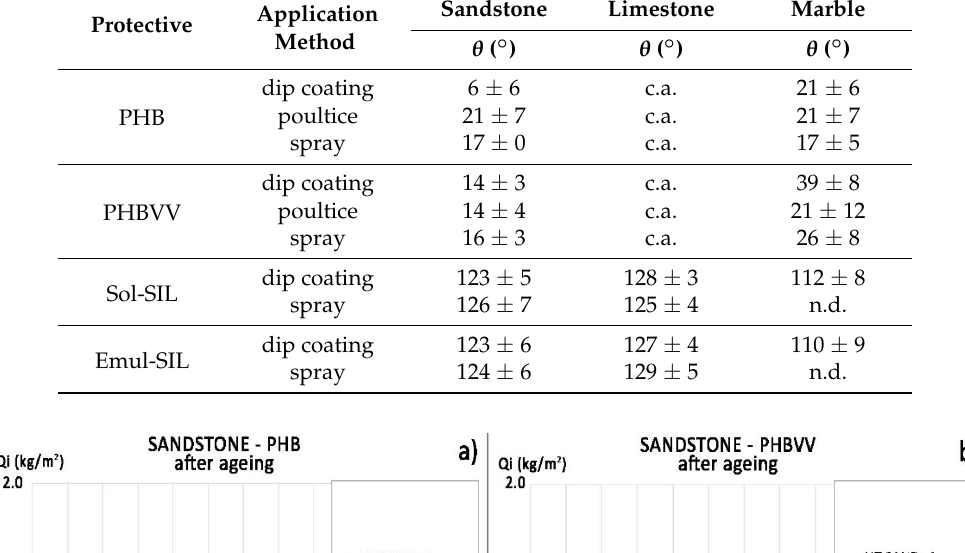
Table 12. Static contact angle values determined after the artificial ageing (c.a.: complete absorption; n.d.: not determined).